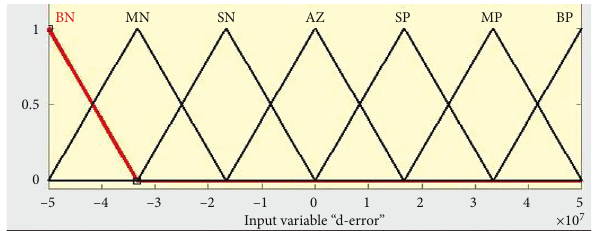
Figure 5: Input membership function for change of current error.